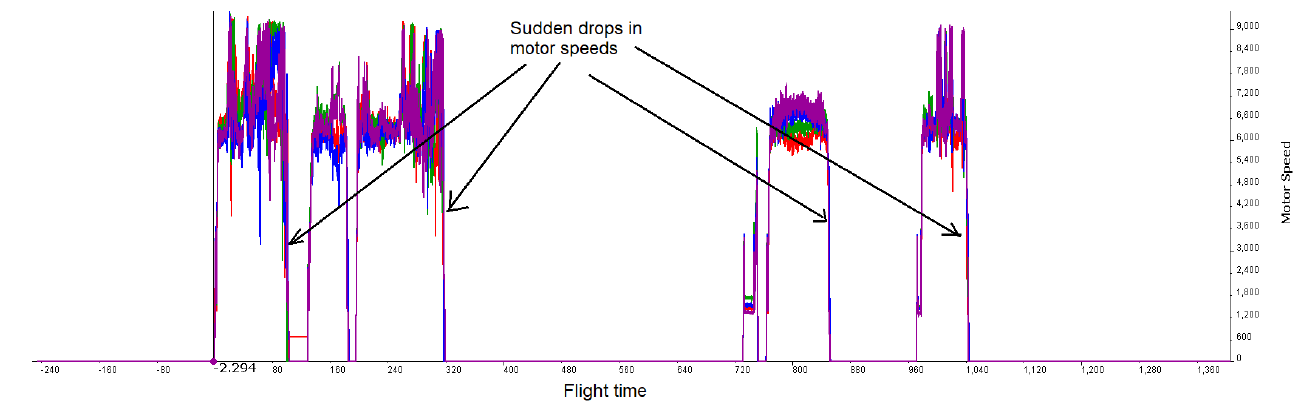
Figure 6. Sudden drop in motor speeds observed in the